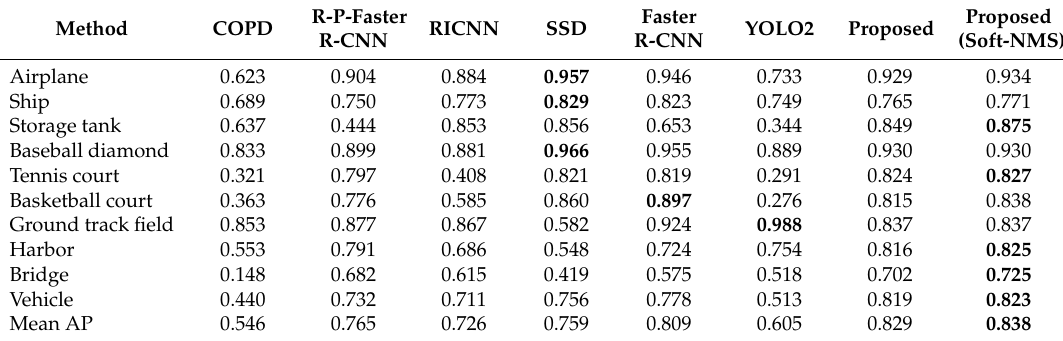
Table 5. The AP values of compared object detection methods on NWPU VHR-10 dataset.